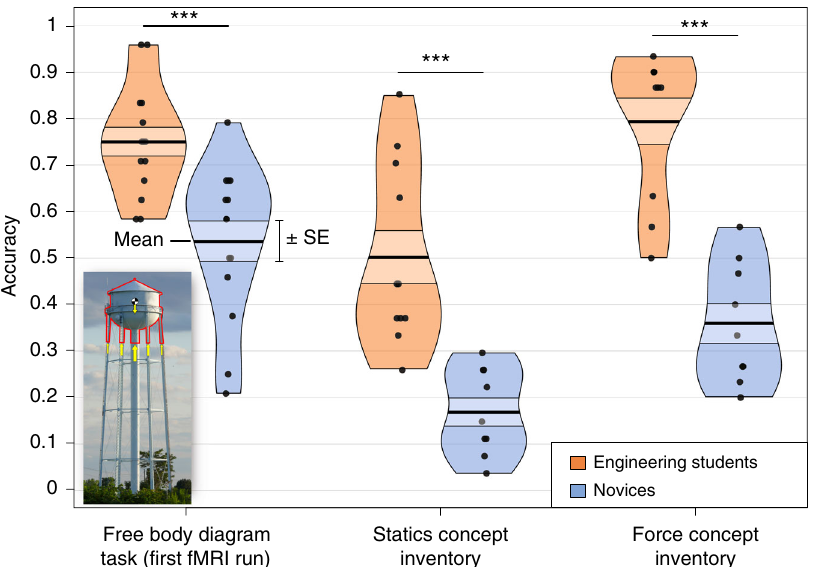
Fig. 1 Outcome measures: accuracy scores by group. Group performance on each outcome measure: FBD task performance at the fi rst fMRI run, SCI accuracy score, and FCI accuracy score (between-group t test signi fi cance values: * = p < 0.05, ** = p < 0.01, *** = p < 0.001). Inset: example stimulus from the FBD task. (For a larger version of this example stimulus, see Supplementary Fig.